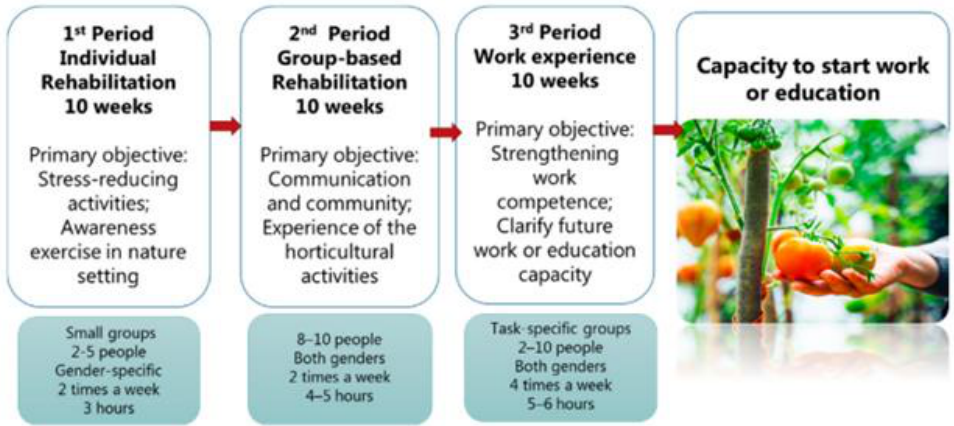
Figure 1. A nature-based therapy and horticulture program aimed at increasing affiliation to the labor market and improve mental well-being.